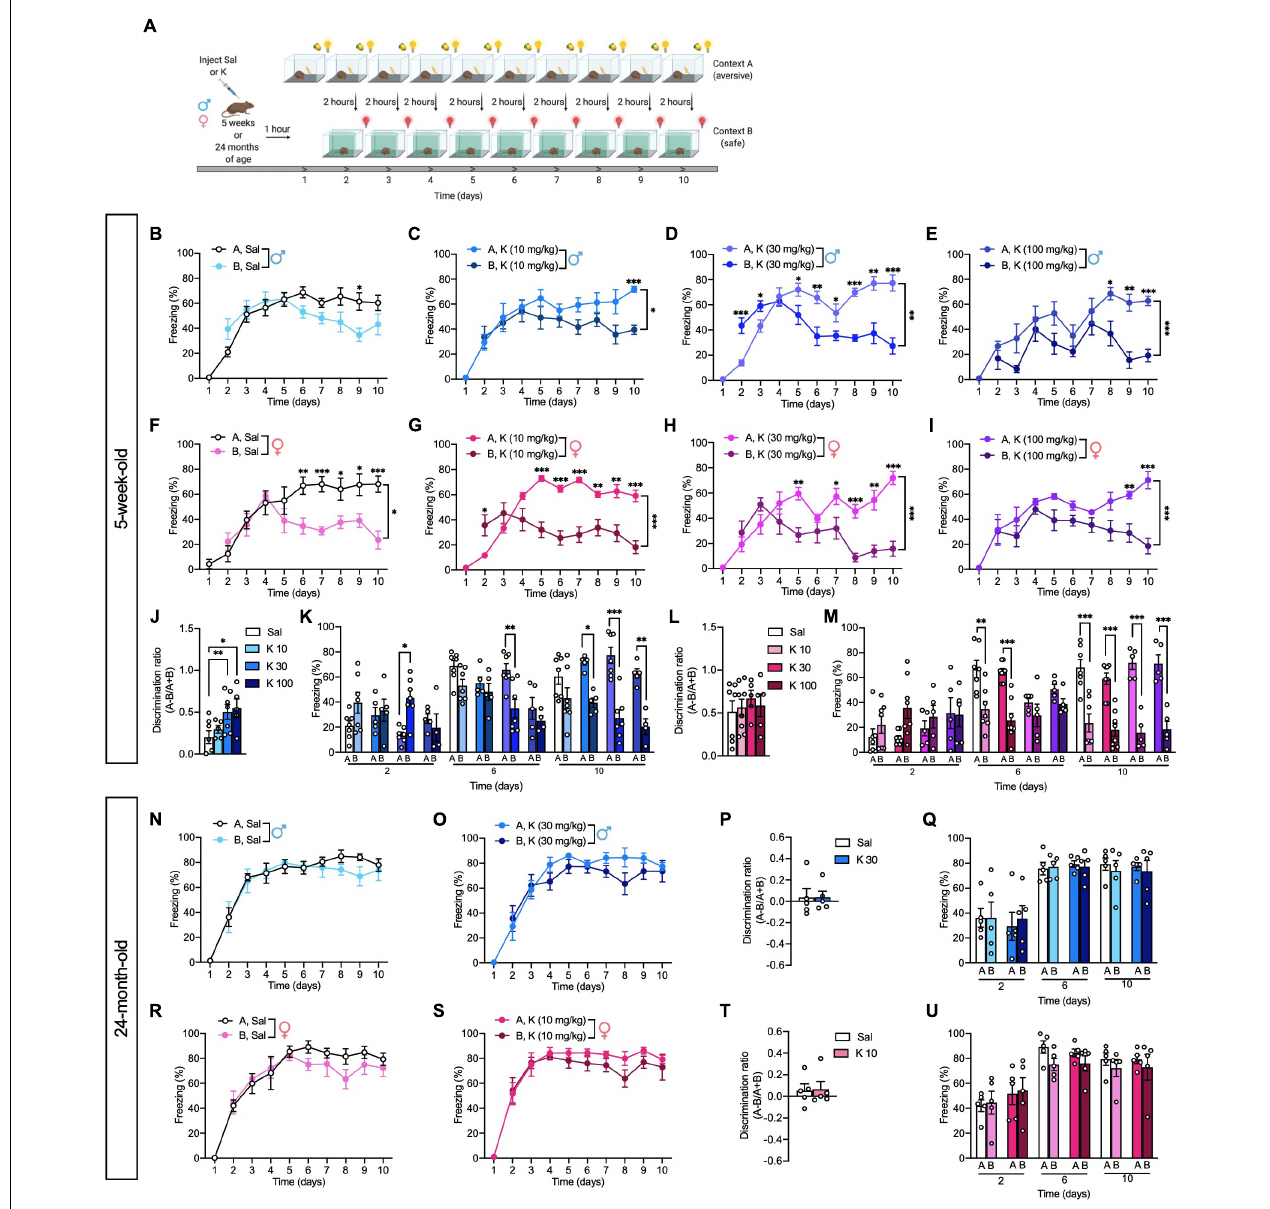
FIGURE 3 | Acute ( R,S )-ketamine facilitates contextual fear discrimination in adolescent but not aged male mice. (A) Experimental design. (B) Saline-injected male mice could not discriminate between the two contexts. (C) ( R , S )-ketamine-injected male mice (10 mg/kg) could discriminate between the two contexts only on day 10. (D) ( R , S )-ketamine-injected male mice (30 mg/kg) initially had increased fear generalization on day 2, but could discriminate starting on day 5. (E) ( R , S )-ketamine-injected male mice (100 mg/kg) could discriminate between the two contexts starting from day 8. (F) Saline-injected female mice could discriminate between the two contexts starting on day 6. (G,H) ( R , S )-ketamine-injected female mice (10 and 30 mg/kg) could discriminate between the two contexts starting on day 5. (I) ( R , S )-ketamine-injected female mice (100 mg/kg) could discriminate starting on day 9. (J) ( R , S )-ketamine-injected male mice (30 or 100 mg/kg) exhibited improved discrimination ratios on day 10. (K) ( R,S )-ketamine-injected male mice (30 mg/kg) showed increased fear generalization on days 2 and 3, however, they could discriminate between the two contexts on day 6. On day 10, ( R,S )-ketamine-injected male mice (all doses) could discriminate between the two contexts. (L) All groups of female mice exhibited comparable discrimination ratios on day 10. (M) Saline- or ( R,S )-ketamine-injected female mice could not discriminate between the two contexts on day 2. On day 6 Saline- or ( R , S )-ketamine-injected female mice (10 mg/kg) could discriminate. On day 10, all groups of mice could discriminate. (N,O) Twenty-four-month-old male saline- or ( R,S )-ketamine-injected mice could not discriminate between the two contexts over the 10 days. (P) Both groups of male mice exhibited comparable discrimination ratios on day 10. (Q) On Days 2, 6, and 10, all groups exhibited comparable freezing. (R,S) Twenty-four-month-old saline- or ( R,S )-ketamine-injected female mice could not discriminate between the two contexts over the 10 days. (T) Both groups of female mice exhibited comparable discrimination ratios on day 10. (U) On Days 2, 6, and 10, all groups exhibited comparable freezing. ( n = 5–10 mice per group). Error bars represent ± SEM. ∗ p < 0.05, ∗∗ p < 0.01, ∗∗∗ p < 0.0001. Sal, saline; K, ( R,S )-ketamine; mg, milligram; kg, kilogram.